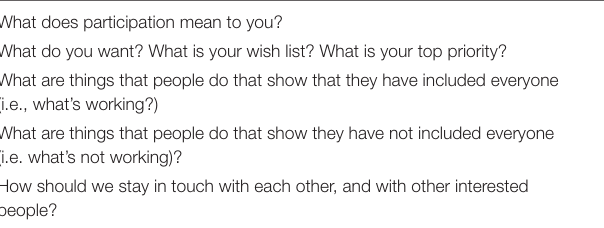
TABLE 1 | Sample questions for the large group discussions. What does participation mean to